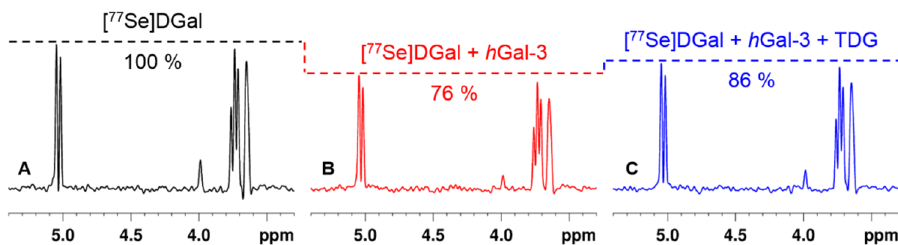
Figure 2. 77 Se-enriched selenodigalactoside ([ 77 Se]DGal) binding to h Gal-3 and its competitive displacement by thio-di-galactoside (TDG) monitored with the 1 H- 77 Se CPMG-HSQMBC method. 1D 1 H ( F2 ) cross sections of 2D 1 H- 77 Se CPMG-HSQMBC experiments (3 min each) performed on samples of ( A ) [ 77 Se]DGal (2 mM) in the absence of h Gal-3; ( B ) [ 77 Se]DGal (2 mM) and h Gal-3 (29 µ M, i.e., molar ratio = 1:0.0145); and ( C ) [ 77 Se]DGal (2 mM), TDG (2 mM), and h Gal-3 (29 µ M, i.e., molar ratio = 1:1:0.0145). Each spectrum was measured and plotted with identical parameters. At the top of the spectra, dashed lines indicate the overall intensity change of correlation signals of [ 77 Se]DGal. In the presence of h Gal-3 ( B ), the signal intensity decreased compared with that of free [ 77 Se]DGal in ( A ). The addition of TDG causes a rebound of the attenuated [ 77 Se]DGal signals ( C ), indicating its competitive displacement by TDG.